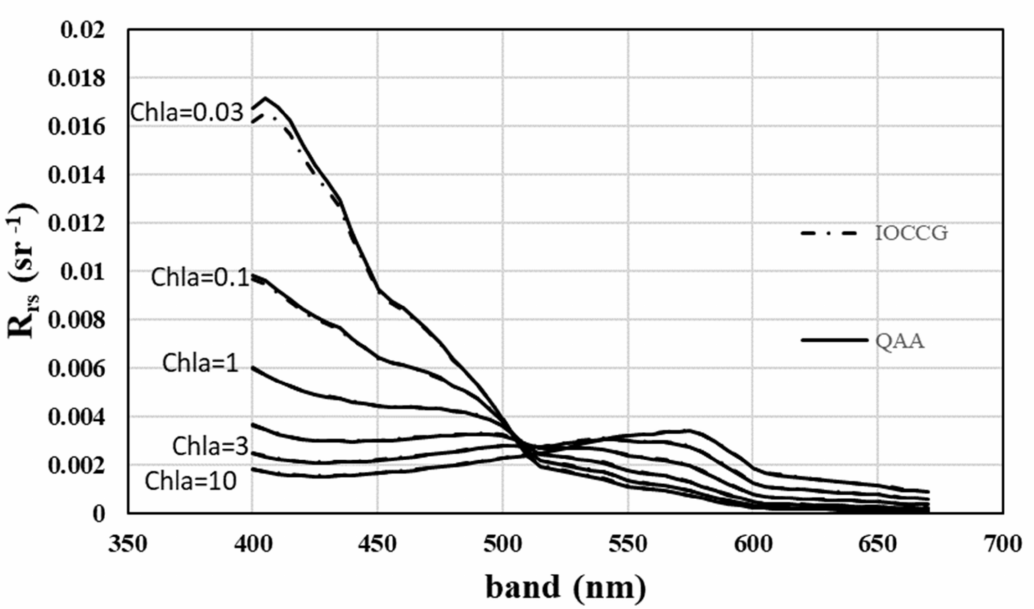
Figure 6. Difference in R rs ( λ ) between formula (8) and (cid:60) ≈ 0.5291 (IOCCG, 2006), when the concentration of chlorophyll